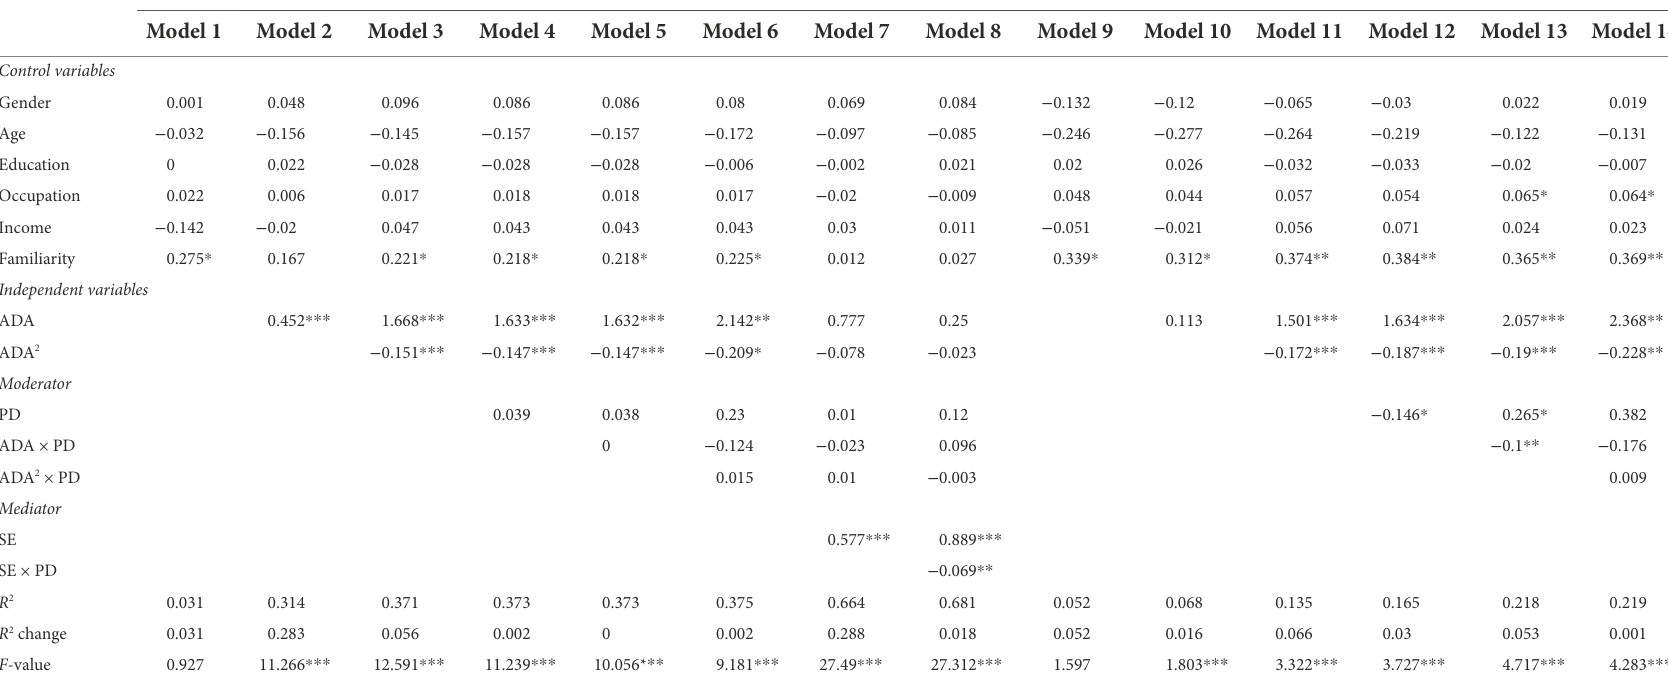
TABLE 3 Regression